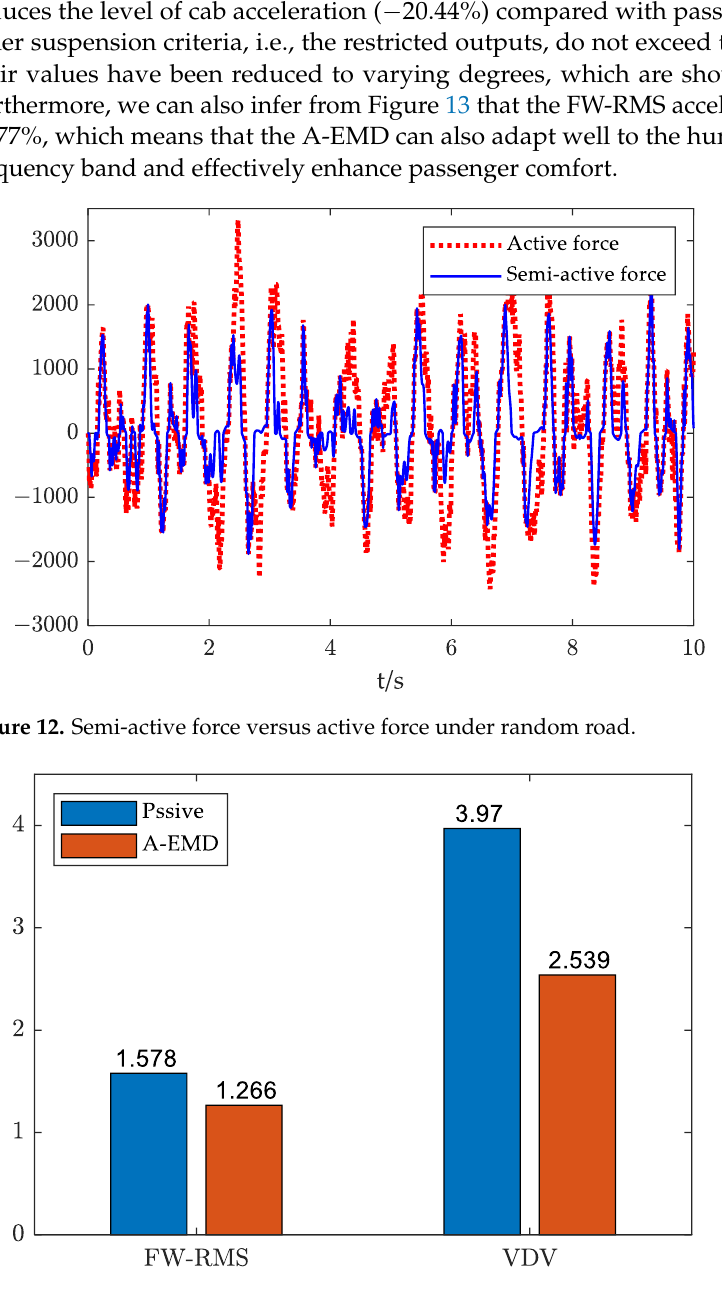
Figure 13. Evaluation parameters.